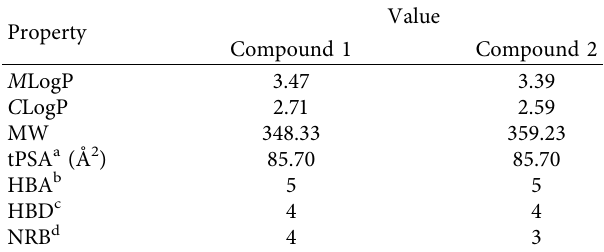
Table 2: In silico pharmacokinetics properties predictions for compound.